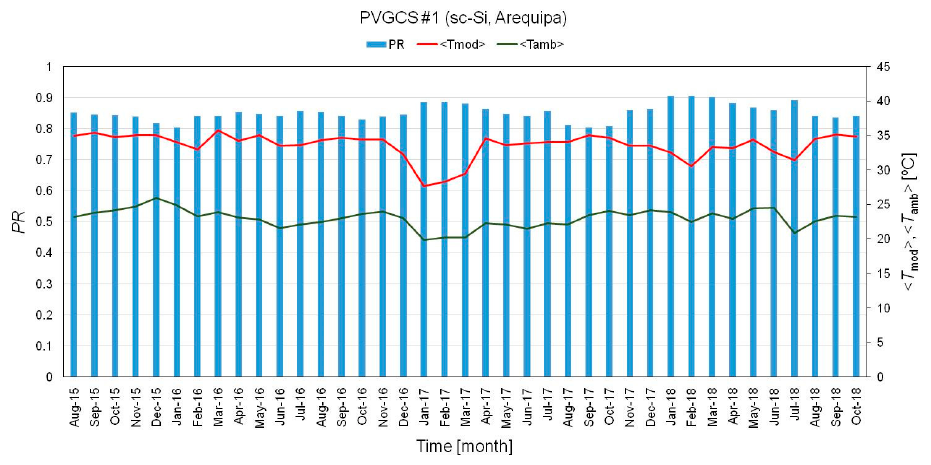
Figure 6. Values of PR , < T amb >, and < T mod > for PVGCS #1 over the period under scrutiny. N.B. only values of temperature recorded during daytime are considered in the calculations.